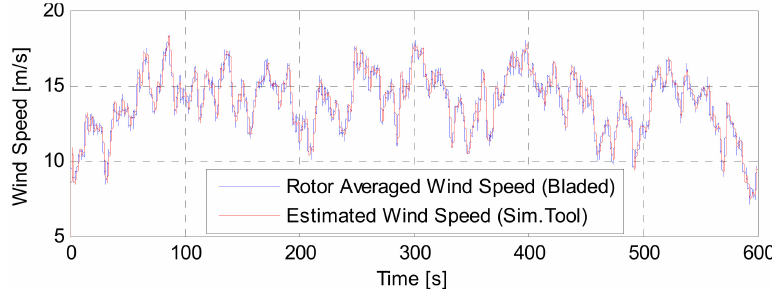
Figure 12. Comparison of the wind speed estimator results with those obtained with DNVGL-Bladed.